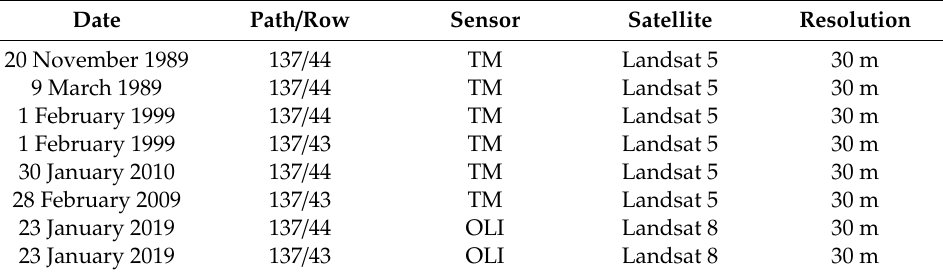
Table 1. Characteristics of Landsat data for the DMDP area